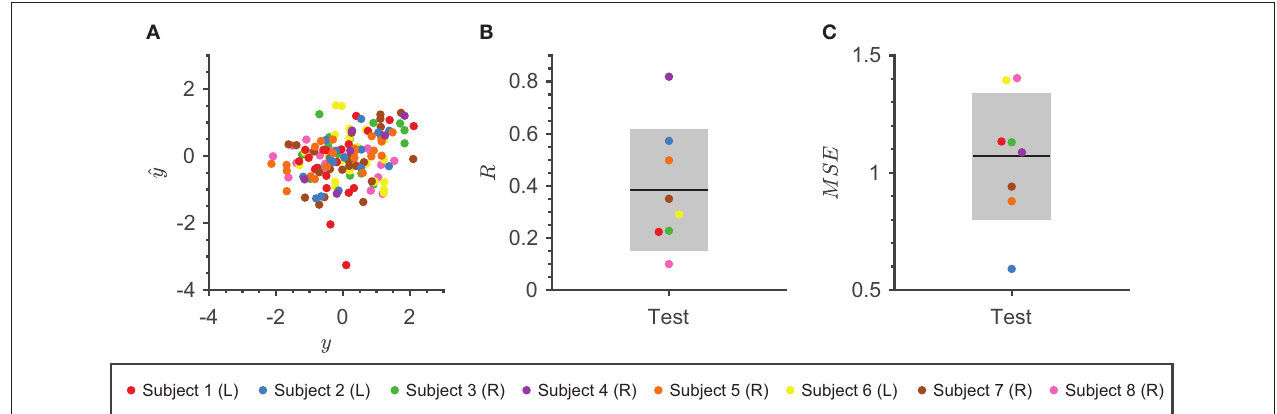
FIGURE 4 | Model Performance. (A) Scatter plot of actual speed vs. predicted speed using the final combined model with the highest R for each subject over 100 iterations on the test trials. Each subject is denoted as a different color point. (B) The average R between the actual speed and predicted speed using the final combined models across 100 iterations on the test set for eight subjects. Each subject is denoted as a different color point. The mean of the metric is represented by the black line and one standard deviation is represented by the gray rectangle. (C) The average MSE between the actual speed and predicted speed using the final combined models across 100 iterations on the test set for eight subjects. Each subject is denoted as a different color point. The mean of the metric is represented by the black line and one standard deviation is represented by the gray rectangle.